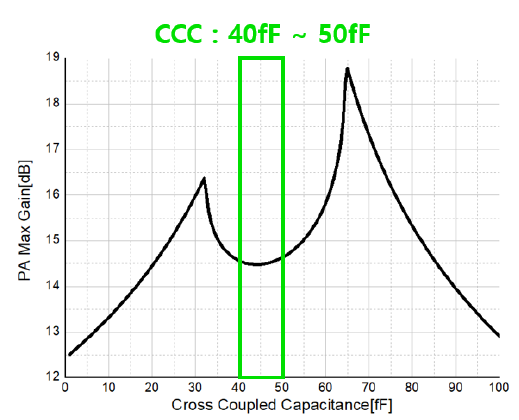
Figure 19. Maximum gain simulation according to CCC value as in Figure 9.